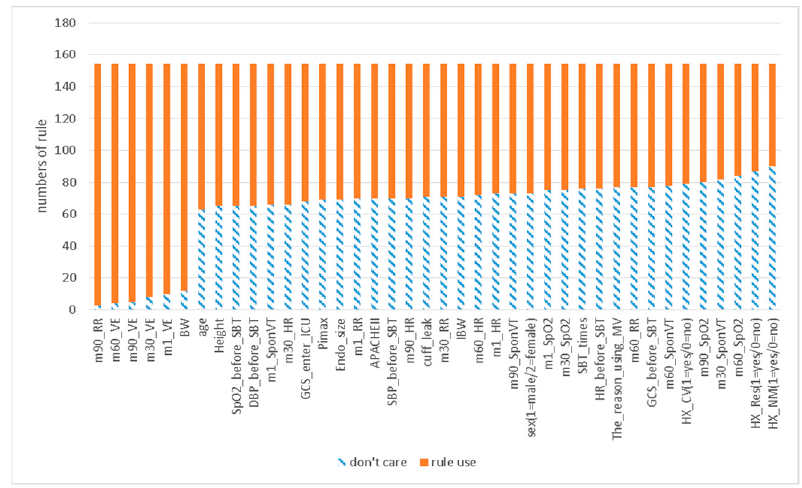
Figure 5. Distribution of the number of rules that use each variable.